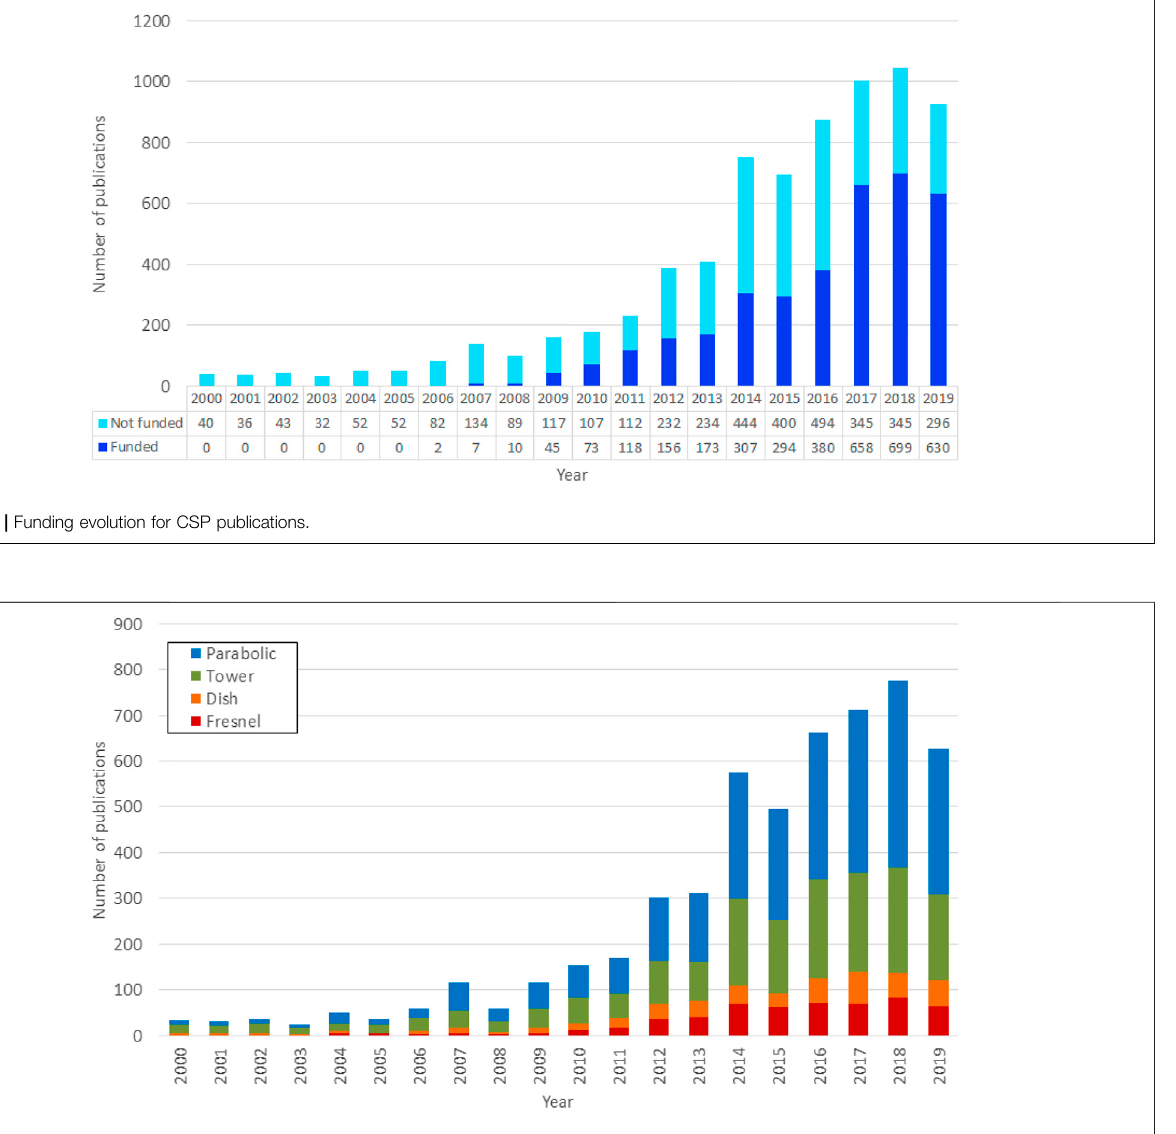
FIGURE 11 | Number of publications per year for each CSP